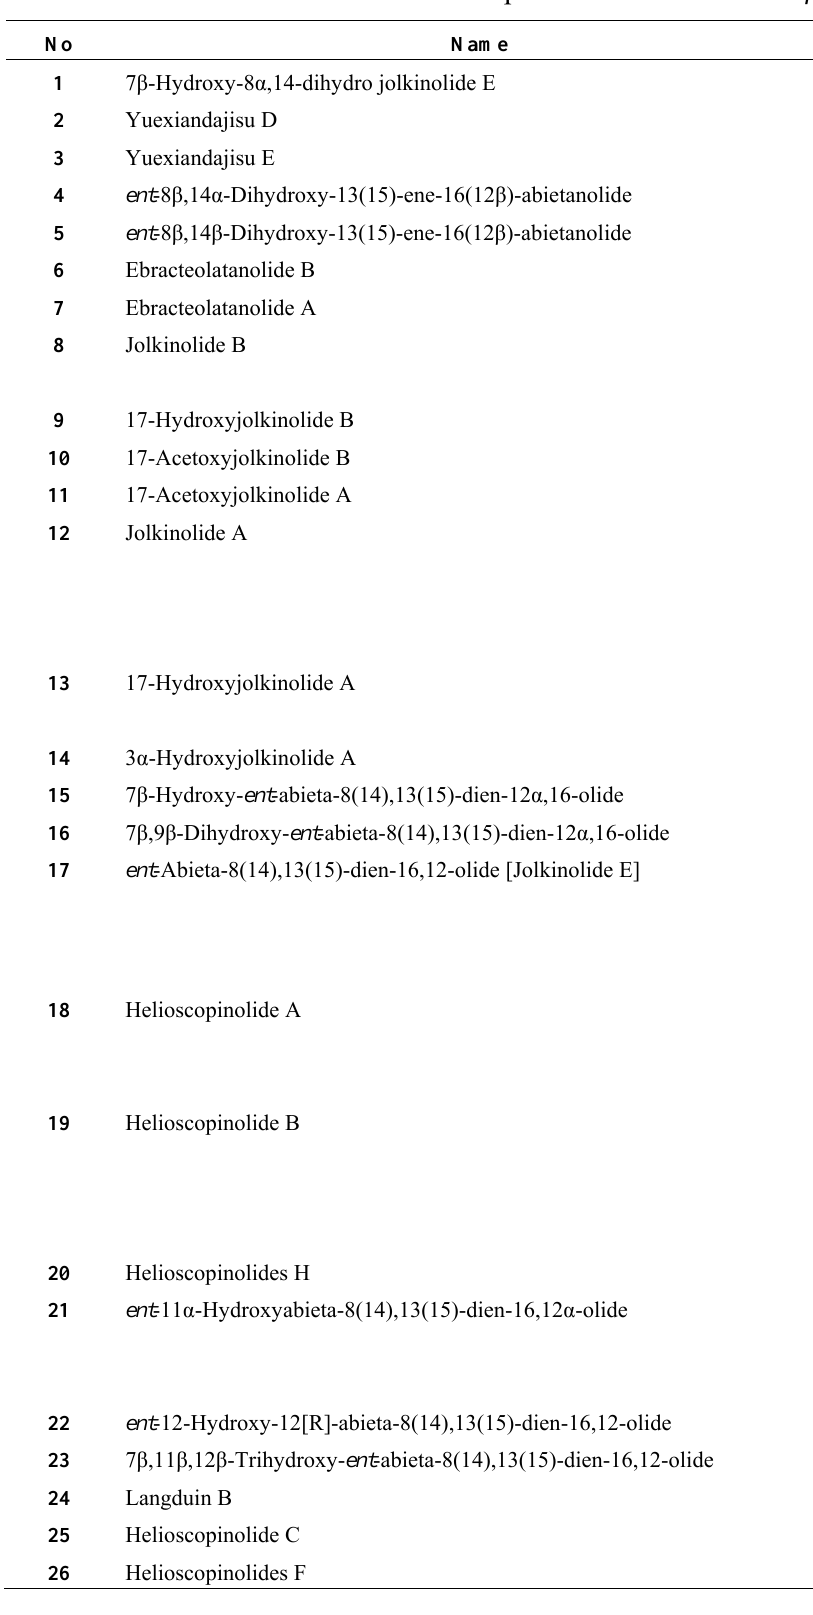
Table 1. Abietane diterpenoids isolated from Euphorbia